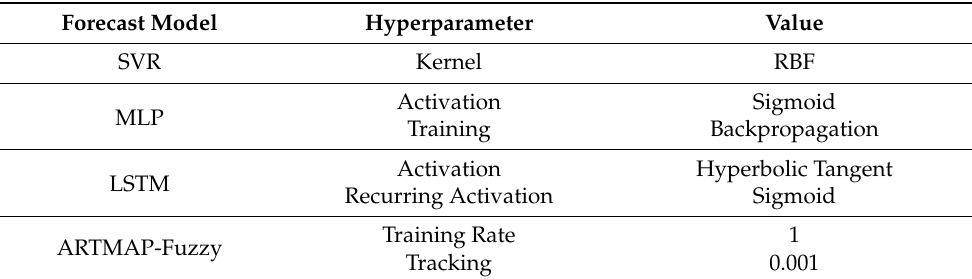
Table 5. Non-optimized